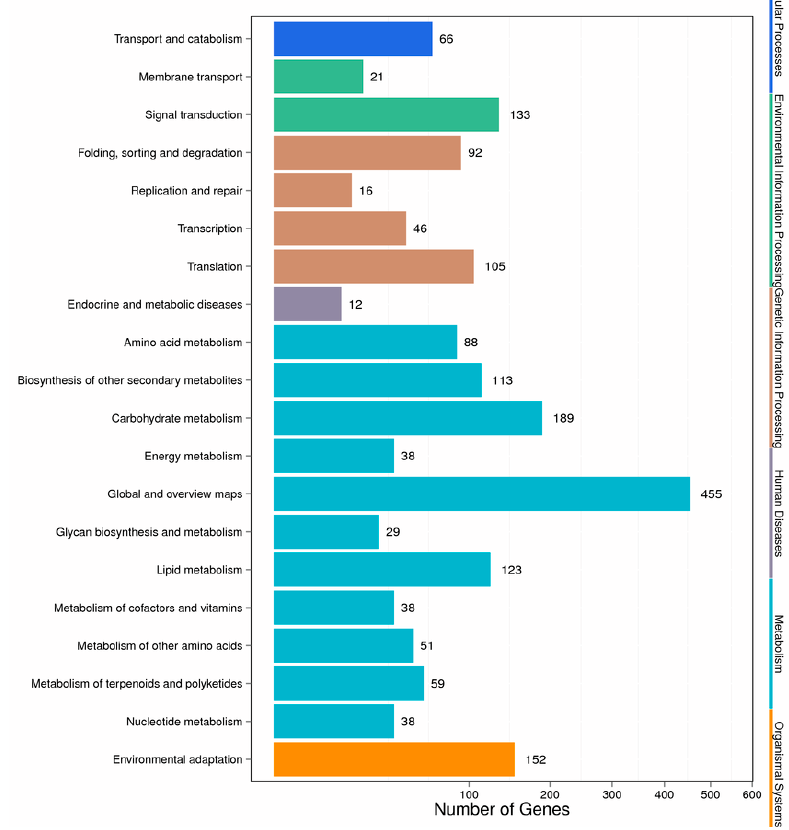
Figure 4. Pathway classification of DEGs. The x-axis represents the number of DEGs. The y-axis represents the pathway name.